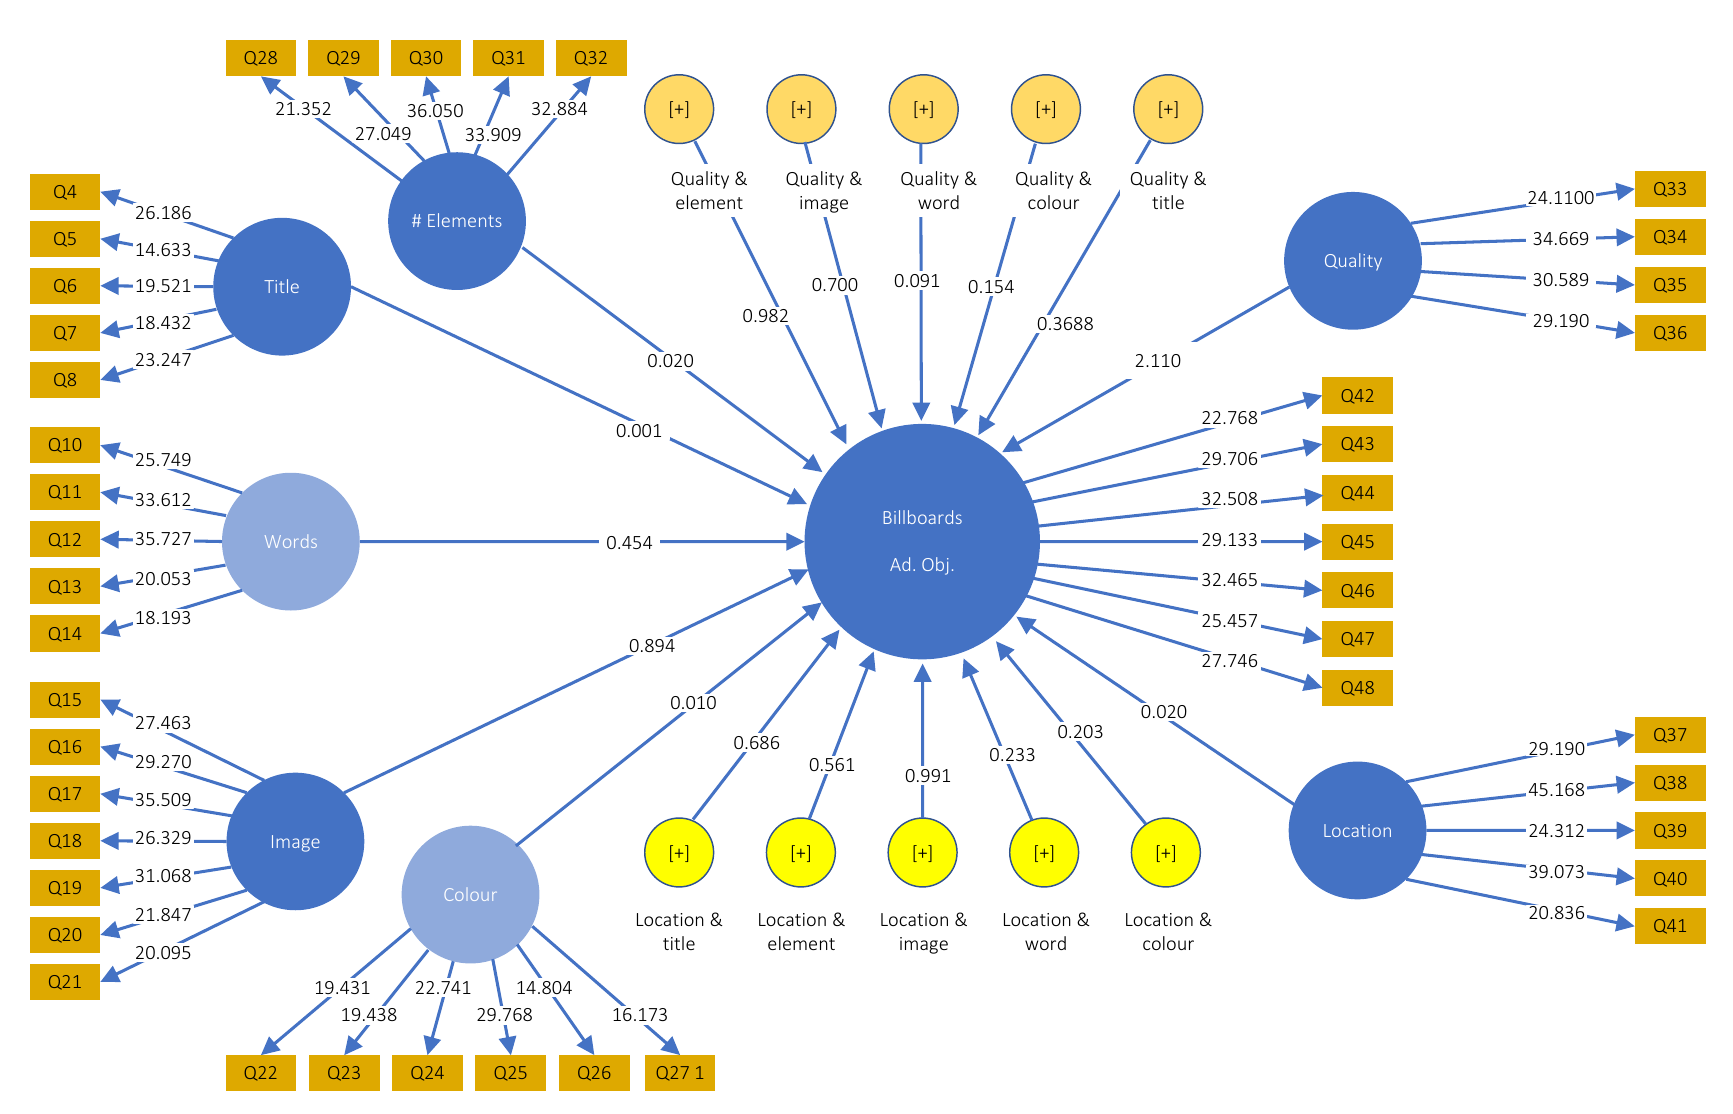
Figure 2. Research path